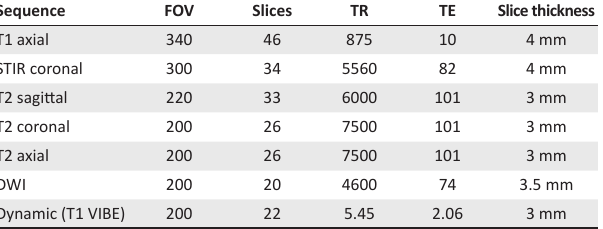
TABLE 1: Parameters for multiparametric prostate magnetic resonance imaging sequences utilised on a 3T scanner at the authors’ institution.